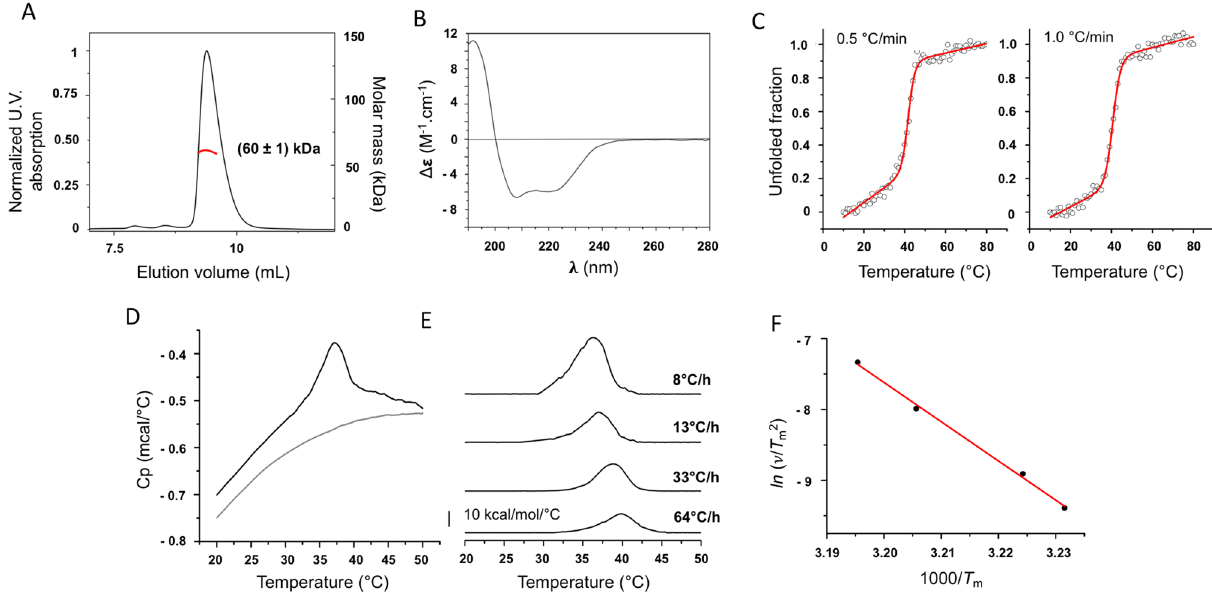
Figure 1. Biophysical characterization of nsP4-CHIKV. ( A ) SEC-MALS analysis of nsP4-CHIKV in solution. The proximity of the estimated molecular weight of (60 ± 1) kDa with the molecular weight of the protein suggests that nsP4-CHIKV is mostly at a monomeric state under the evaluated conditions. ( B ) Secondary structure profile of nsP4-CHIKV by CD spectroscopy. The nsP4-CHIKV spectrum suggests the predominance of helical secondary structures. ( C ) Thermal stability of nsP4-CHIKV probed by CD spectroscopy. The ellipticity at 222 nm as a function of temperature for nsP4-CHIKV was recorded at 0.5 °C/min (left) and 1.0 °C/min (right) and transformed to the protein unfolded fraction. Solid lines are best fits to the CD data using a two-state equilibrium model. The thermodynamic parameters of the protein unfolding transition are summarized in Table 1. ( D ) Scan-rate normalized (13 °C/h) DSC data of the irreversible thermal denaturation of 11.9 μM of nsP4-CHIKV and the corresponding instrumental buffer (50 mM Tris–HCl pH 8,0, 200 mM the scan rate dependence of the nsP4-CHIKV unfolding temperature, T m . The slope yields the activation energy for the irreversible denaturation of nsP4-CHIKV.